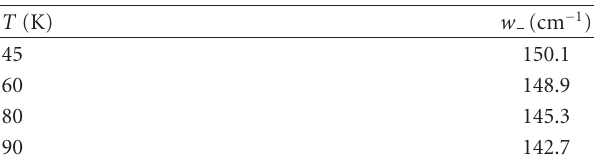
Table 1: Observed values of the soft-mode response frequency w extrapolated at zero pressure at various temperatures in the ferroelectric phase of KDP